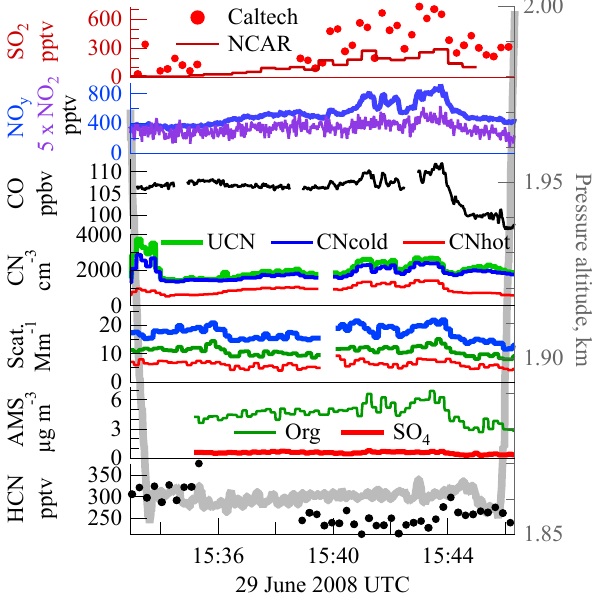
Figure 12. DC-8 plume interception on 29 June. NO 2 , NO y , and SO 2 are consistent with the oil sands plume; low HCN and mini- mally enriched CO indicate that this is not a fire plume.